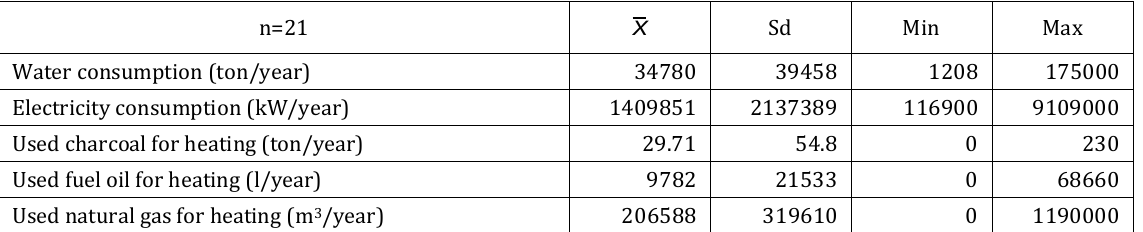
Table 4. Annual consumption of